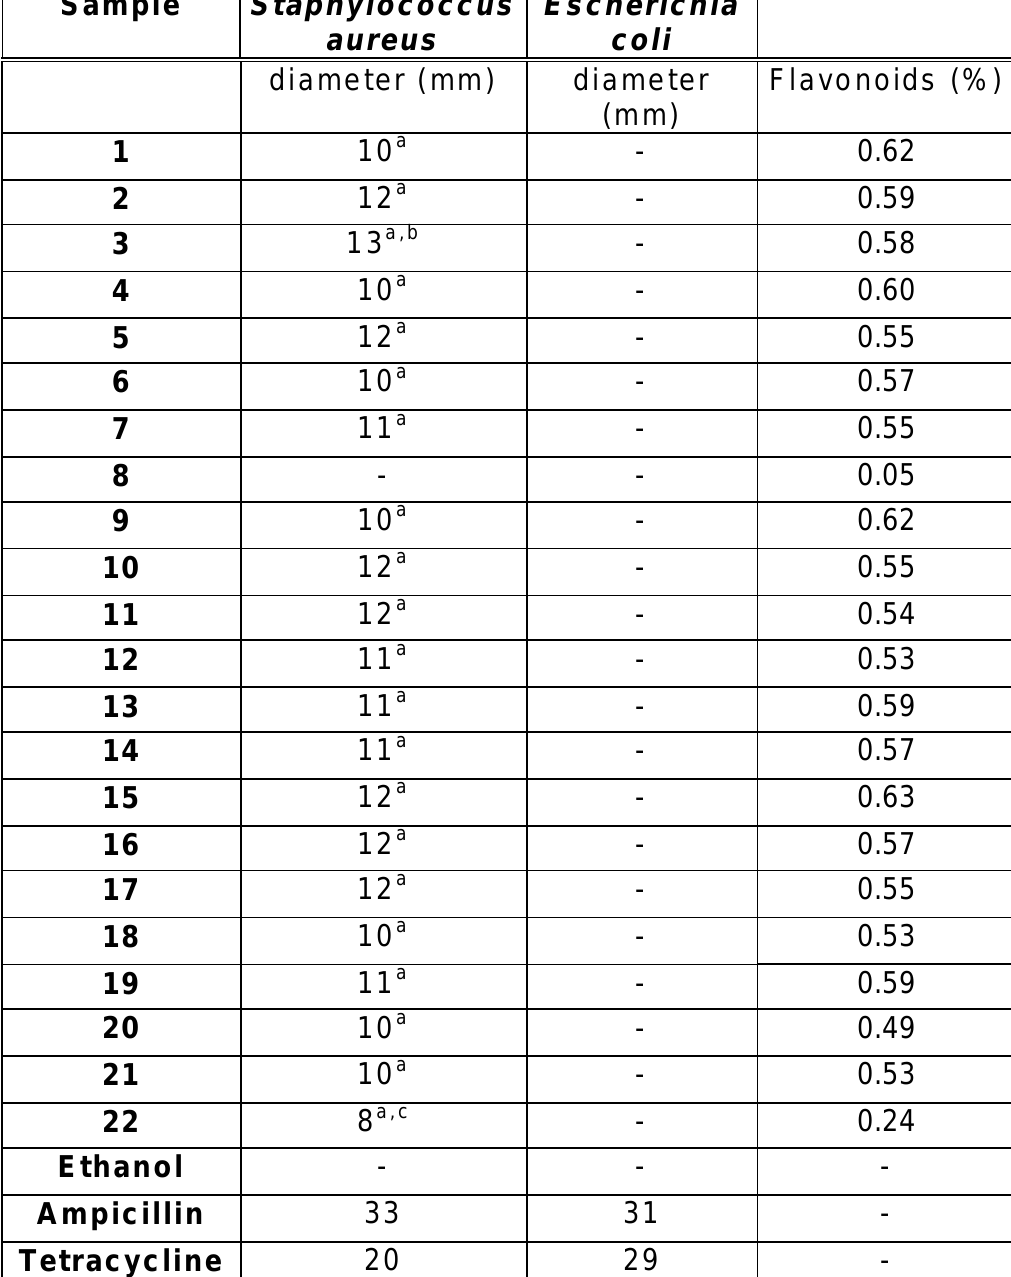
Different letters show statistical difference between propolis samples ( p <